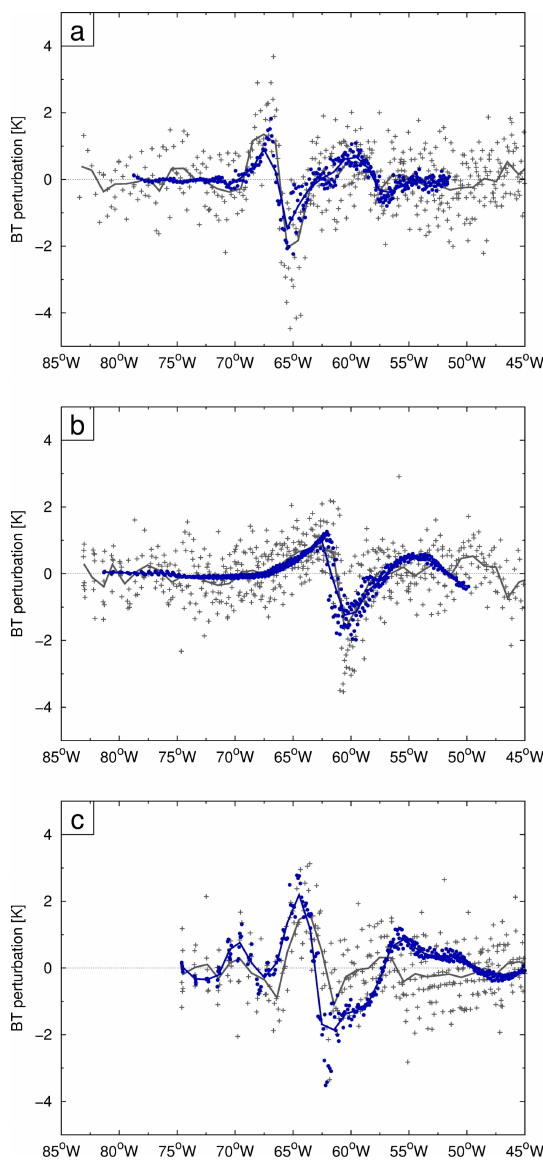
Figure 4. Measured (grey) and mesoscale-model-simulated (blue) brightness temperature fluctuations (K) corresponding to the 666.5cm − 1 AIRS channel along a latitude band intersecting the AP (indicated in Fig. 3) at the time of the CS1 (a) , CS2 (b) , and CS3 (c) mountain wave events. See Table 1 for dates. Model data have been re-sampled on the AIRS measurement grid. Note that the model domain does not always cover the full AIRS swath; therefore re-gridded model data are missing at some longitudes in CS1 and CS2. The solid lines show a 1 ◦ running mean in longitude of the individual temperature